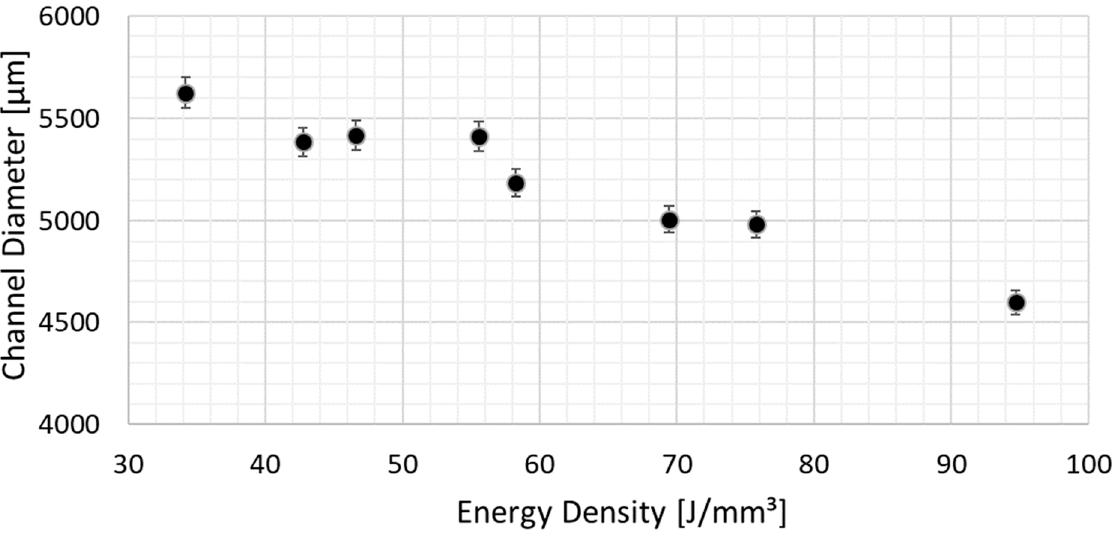
Figure 7. Plot of minimum channel diameters vs. energy density.